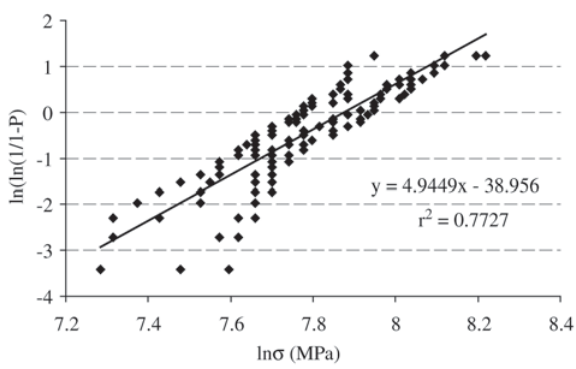
Figure 15. Weibull plots for tensile strength offor glass fibres for all test specimen length.